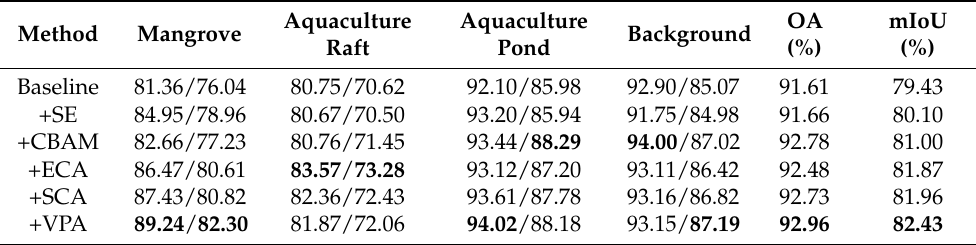
Table 3. Experimental results on the MO-CSSSD. The table shows Precision(%)/IoU(%) for each class. The bold indicates the best